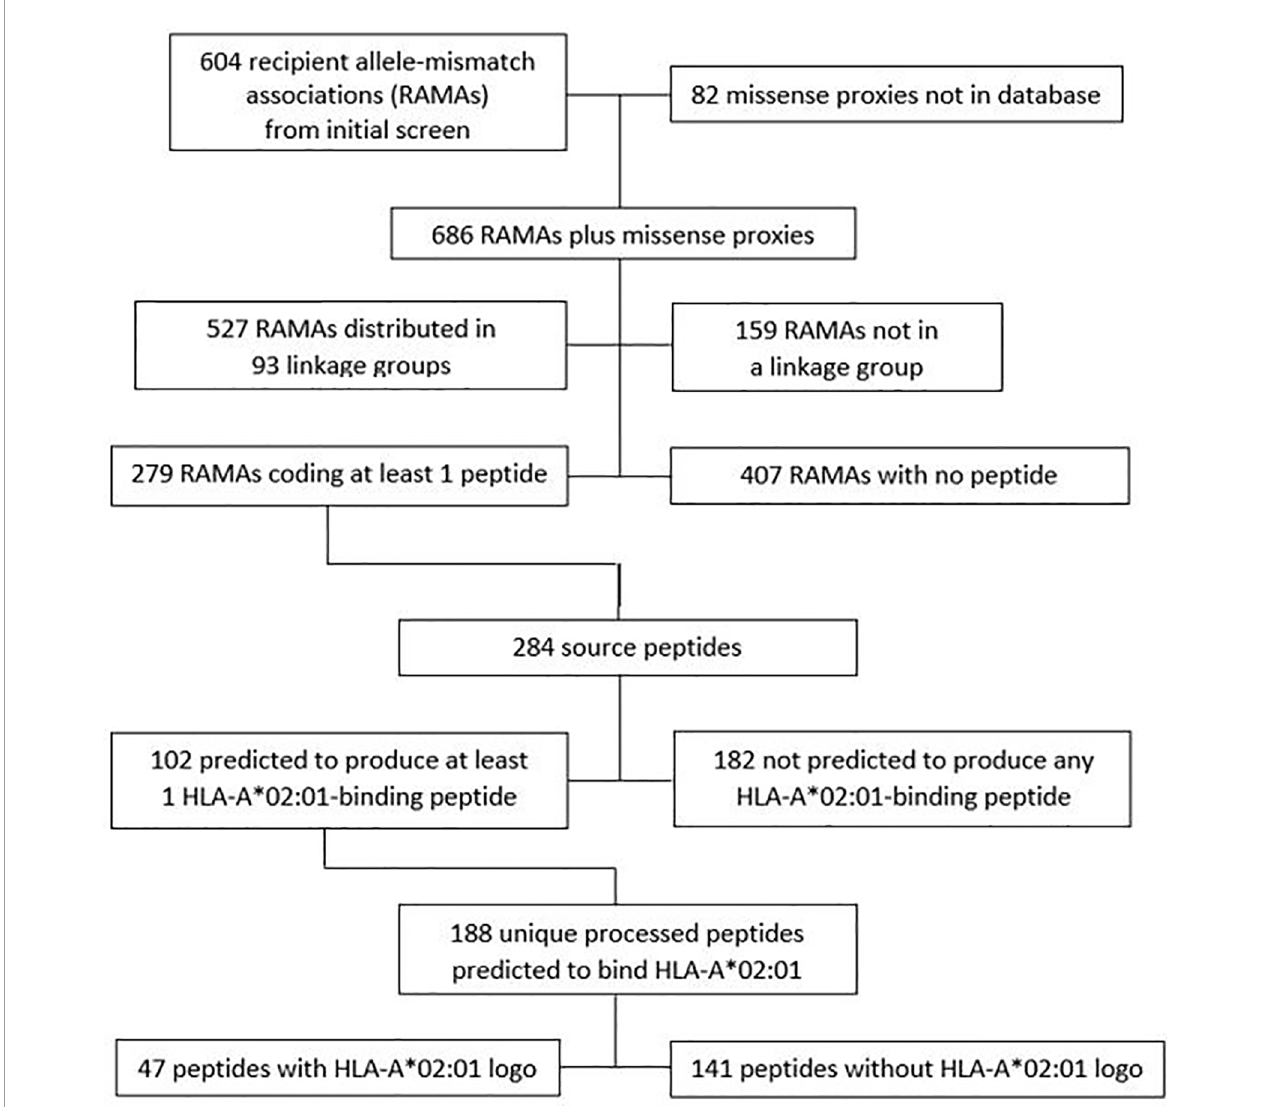
FIGURE 2 | Discovery of recipient allele mismatch associations (RAMAs). Analysis of the discovery cohort identi fi ed 604 RAMAs. An additional 82 proxies were included because the variant encoded a missense peptide and is in LD (r 2 ≥ 0.70) with a noncoding RAMA from the initial screen. 9-mer peptides with leucine, isoleucine, or methionine at the second position and valine, leucine, isoleucine, or methionine in the ninth position were characterized as having a sequence logo or pattern characteristic of peptides that bind to